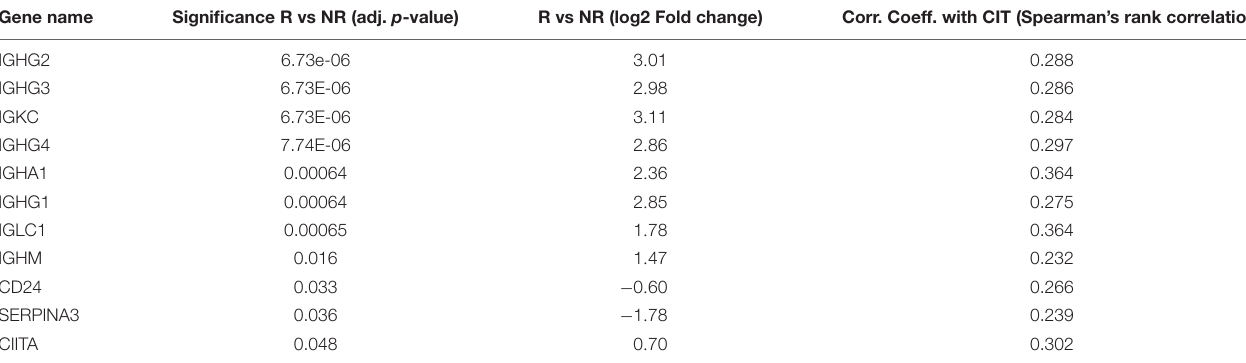
TABLE 5 | Correlation of the differentially expressed genes between rejection (R) and no-rejection (NR) with cold ischemia time